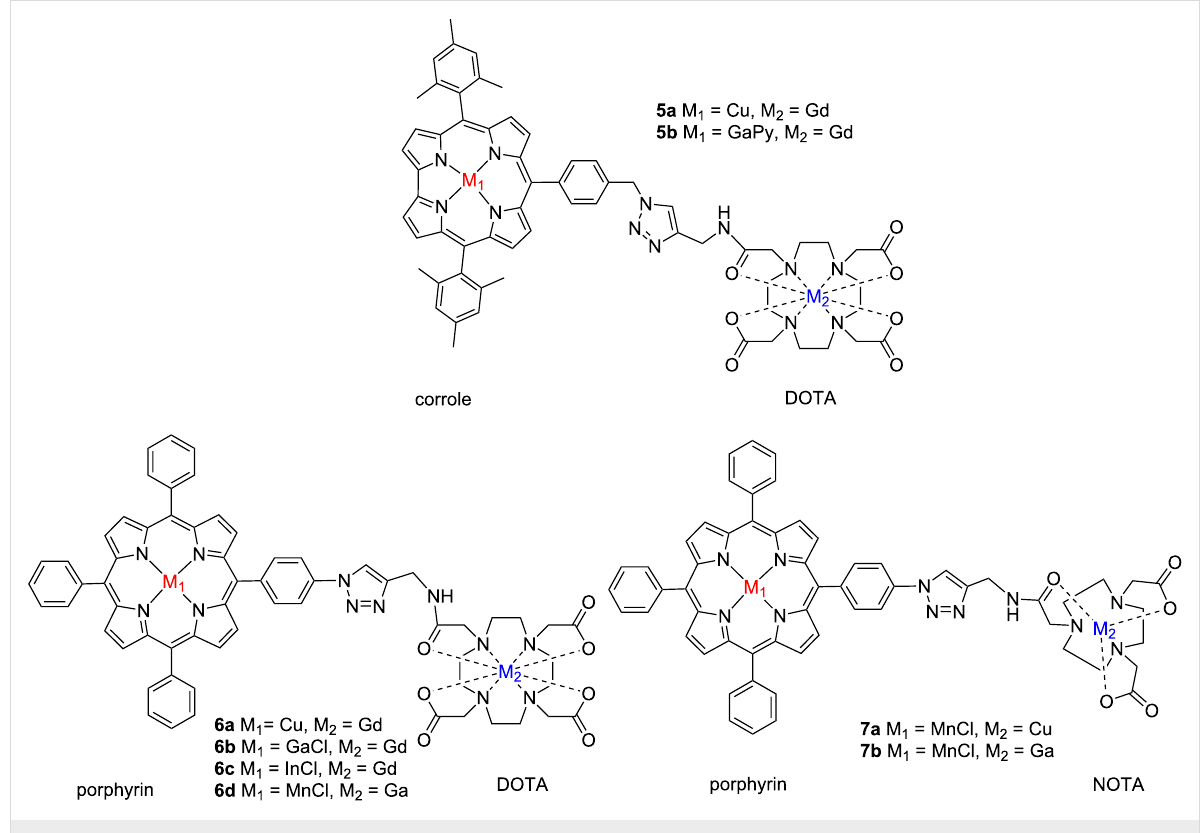
Scheme 1: Structure of different bimetallic complexes 5–7